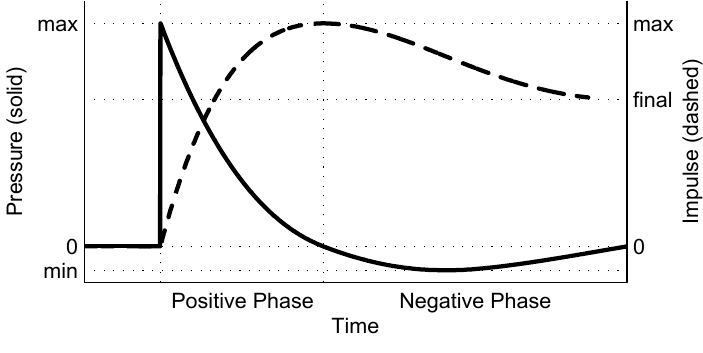
Fig. 1. Typical blast pressure and